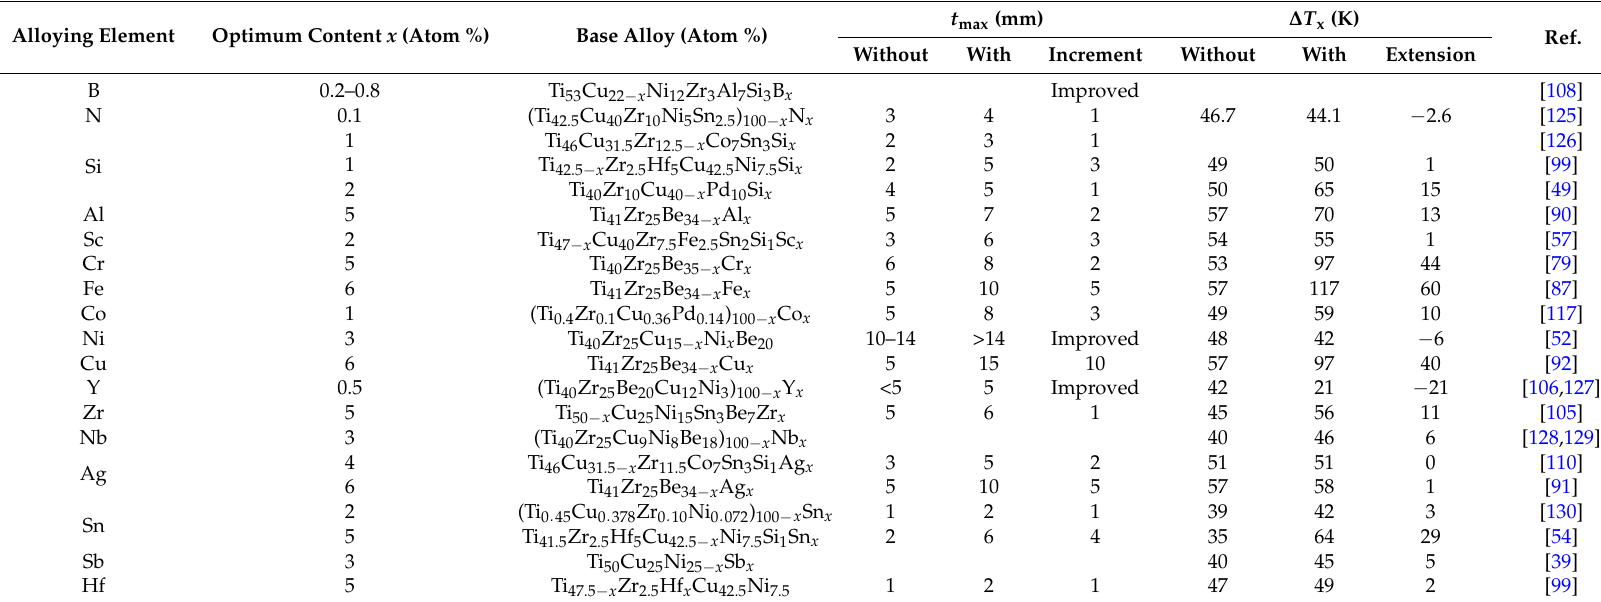
Table 3. Summary of the effects of alloying elements on the glass-forming ability (GFA) of various Ti-based BMGs [39,49,52,54,57,79,87,90–92,99,105–108,110,117,125–130]. Alloying